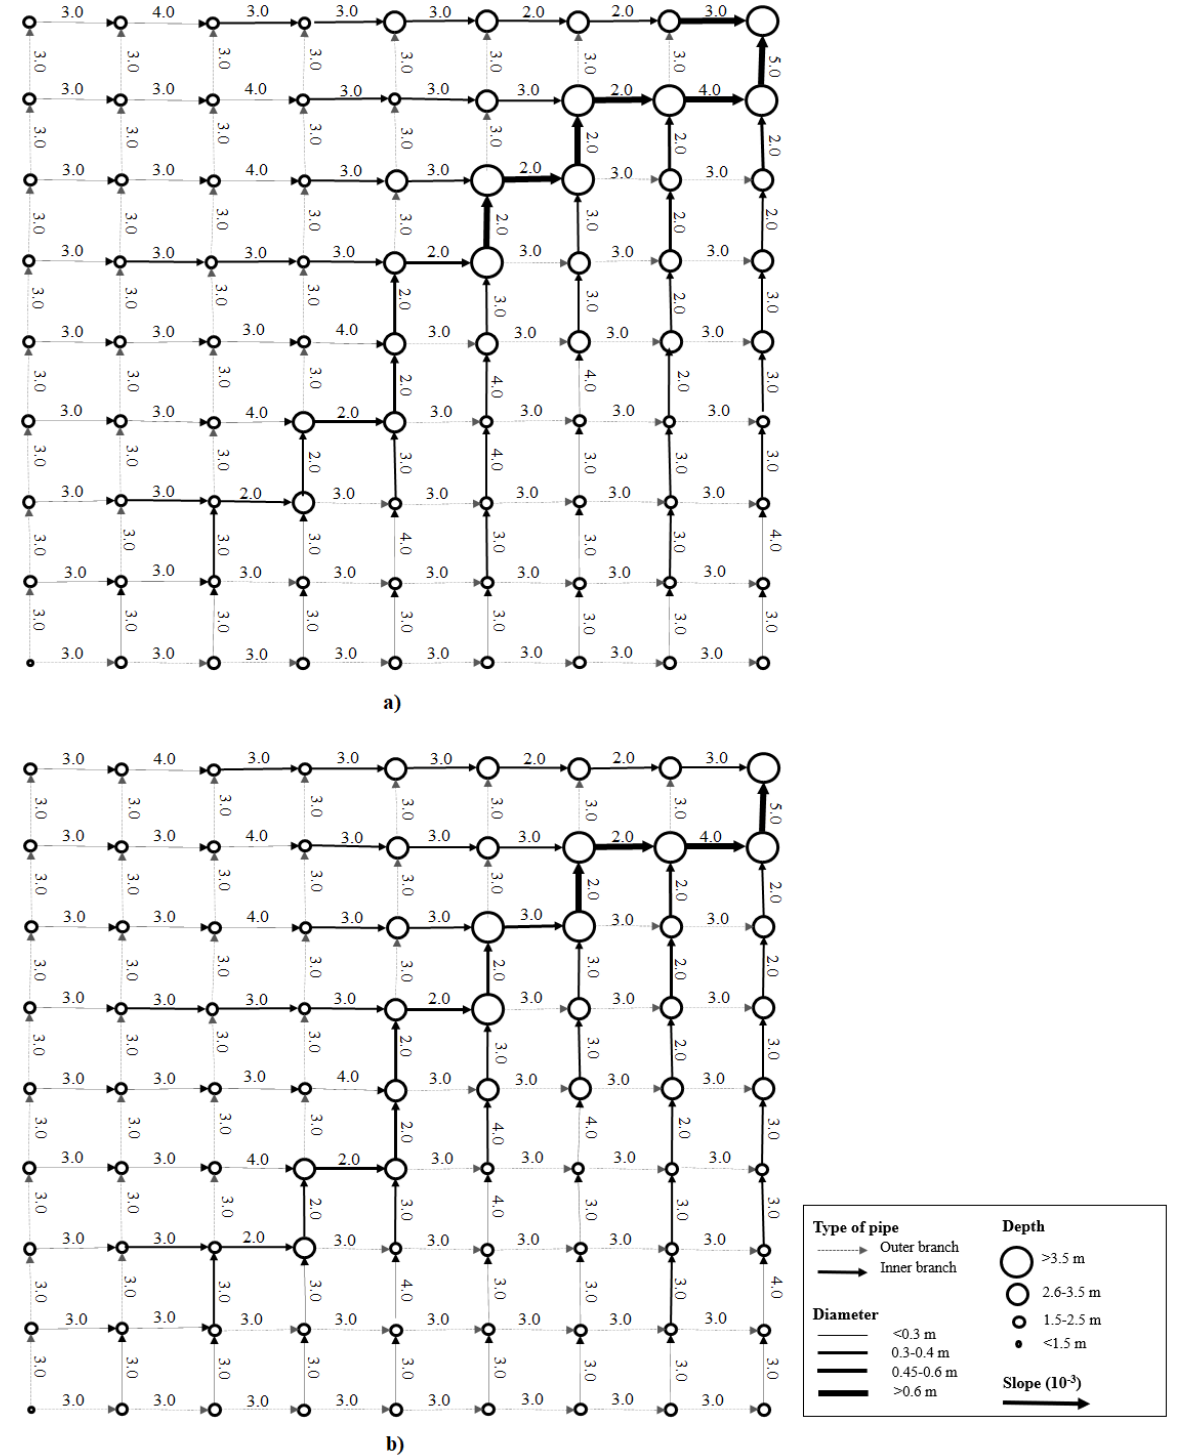
Figure 7. Scheme (not to scale) of the best design of the benchmark network proposed by Moeini and Afshar [46] with ( a ) the cost function of Li and Matthew [34] and ( b ) the cost function of Maurer et al. [47].